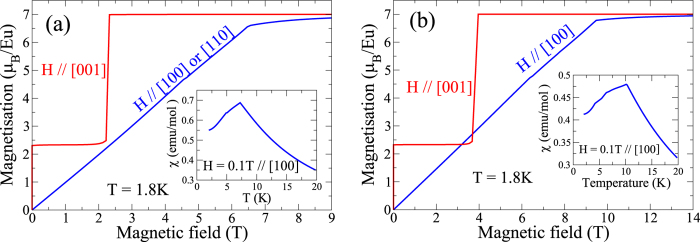
Calculated isothermal magnetization curves at 1.8 K for H || [001] and in the (ab) plane, and, in the insets, calculated susceptibility for H || [100]:(a) with J0 = 0.18 K, J1 = −0.02 K, J2 = −0.17 K and D = −1.3 K, to be compared with data in EuRhAl4Si2 of Figs. 1(a) and 2(a) and (b) with J0 = 0.22 K, J1 = −0.025 K, J2 = −0.29 K and D = −1.5 K, to be compared with data in EuIrAl4Si2 of Figs. 1(b) and 2(b).